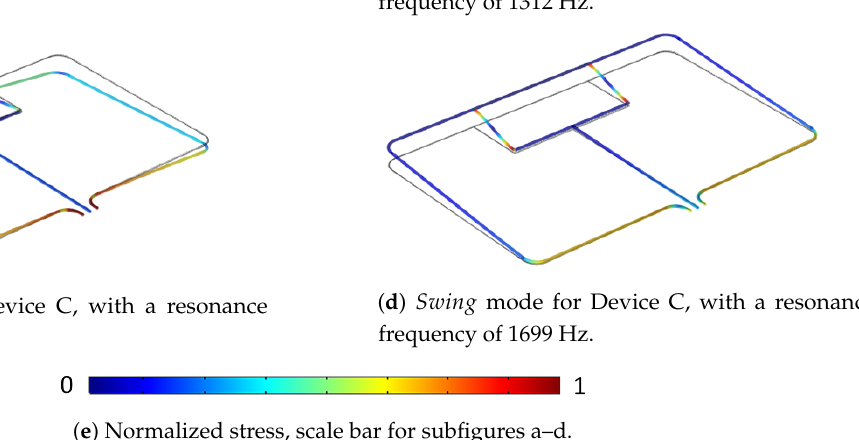
Figure 8. Vibrational modes for the different device types, simulated in COMSOL Multiphysics. ( a,b ) Show that stress is the highest at the channel sections with length l 1 . This is why designs A and B have strain gauges in these sections, optimized for Swing / Twist mode actuation respectively; ( c,d ) show the stress in the connecting membranes. Based on these simulations, device C was designed with four strain gauges as shown in Figure